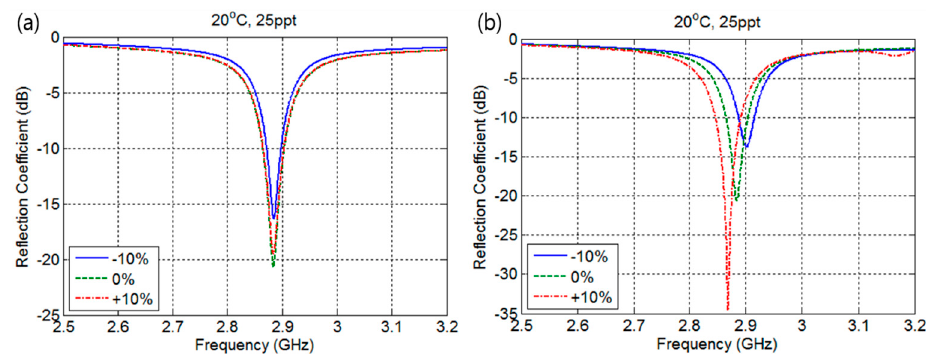
Figure 7. Frequency response according to fabrication error: ( a ) Fabrication error for patch width W ; ( b ) Fabrication error for patch length L .